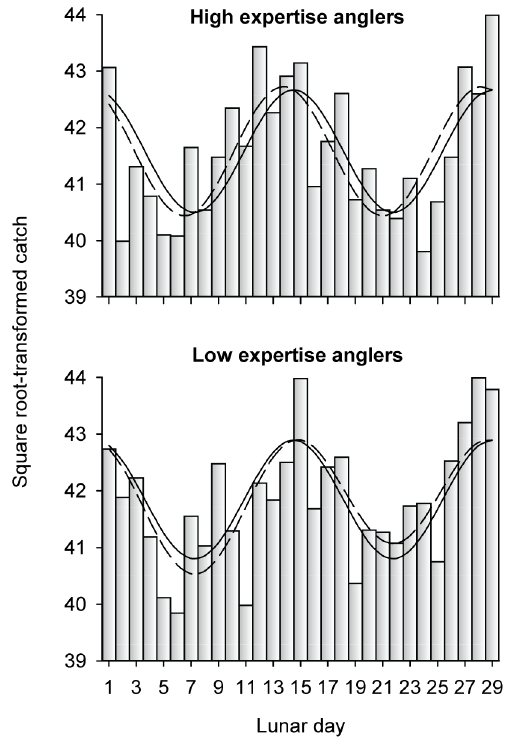
Figure 8. Periodic regression results for catch by high and low expertise anglers. Bars are transformed